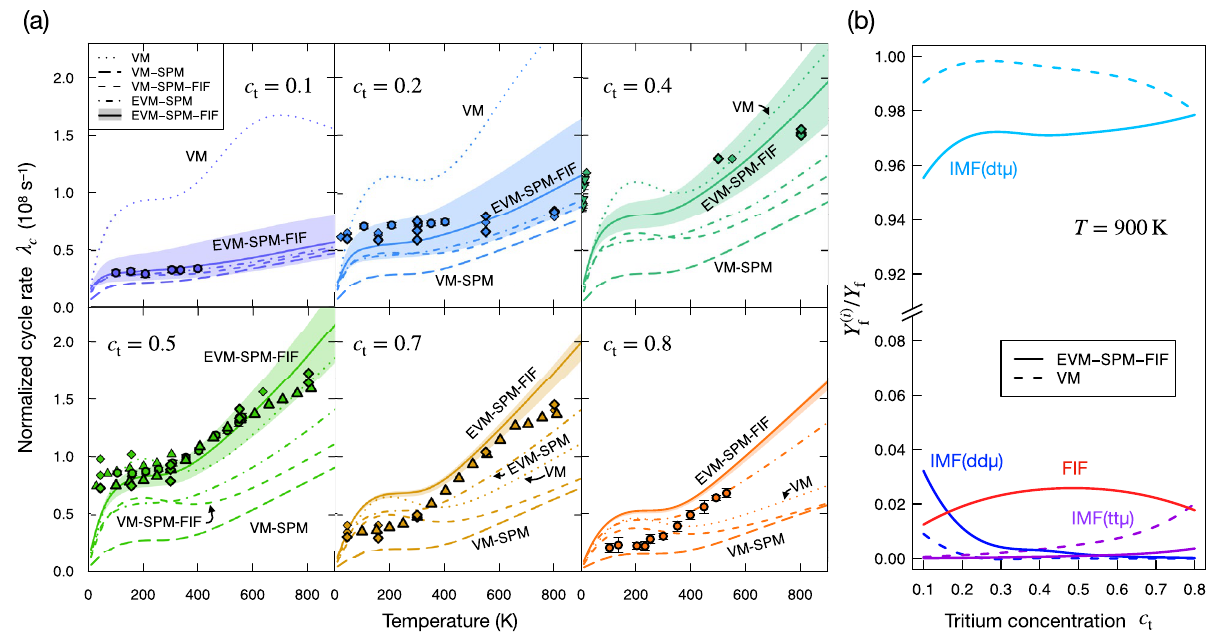
Figure 3. ( a ) Normalized cycle rates (cid:31) c calculated at ϕ = 0.4 are shown as a function of target temperature. The lines are calculation and symbols are experimental results: ◦ 25 , △ 15 , ▽ 21 , ⋄ 22 . The bold symbols denote the values obtained in 0.3 ≤ ϕ ≤ 0.5 conditions. The shade range is drawn in the vicinity of 0.1 ≤ ϒ t µ ≤ 0.9 (the solid line corresponds to ϒ t µ = 0.5 ; dt µ ∗ is assumed to result in t µ and d µ equally). Note that the data points of c t = 0.4 and T < 16 K are from experiments using a solid D 2 /T 2 target 21 . ( b ) Contribution of IMF and FIF to the total ( i ) ( i ) fusion yield as a ratio of fusion yield Y f / Y f where Y f denotes total fusion yield and Y f denotes partial fusion yields whose component i is noted by the lines. The conditions are ϒ t µ = 0.5 , ϕ = 0.4 and T = 900 K.